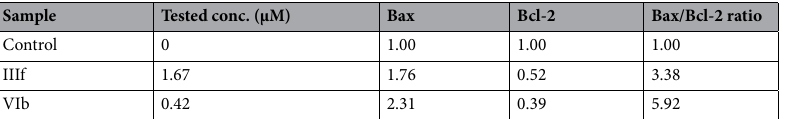
Table 7. Effects of ( IIIf ) and ( VIb ) on Bax and Bcl-2 protein expression in MCF-7 cells. All the data are normalized to β-actin which is set to ‘1’. Values are given as fold changes from the control.